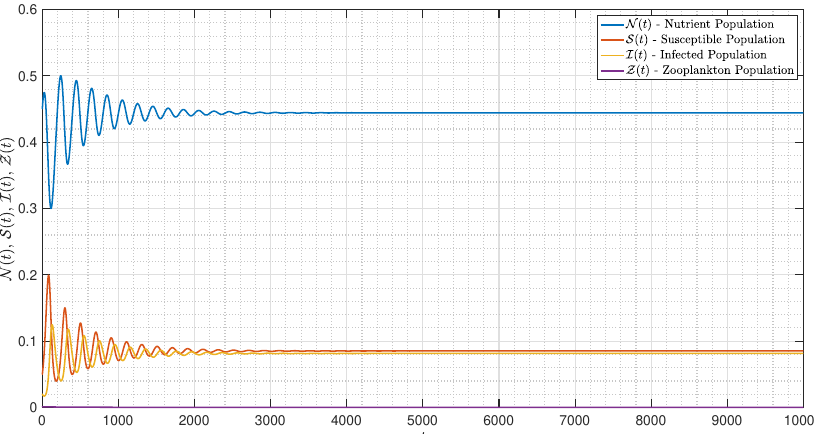
Figure 23. Dynamic of the model (3) for different parameters in Case III with α = 1.000.